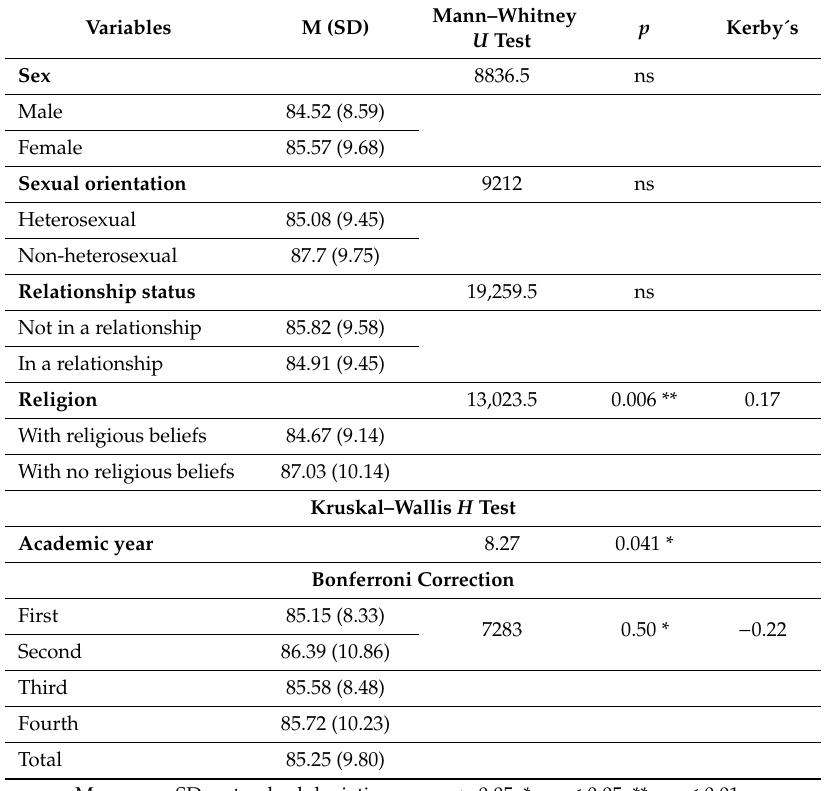
Table 2. Descriptive statistics of the EASE scale according to the sociodemographic variables and academic